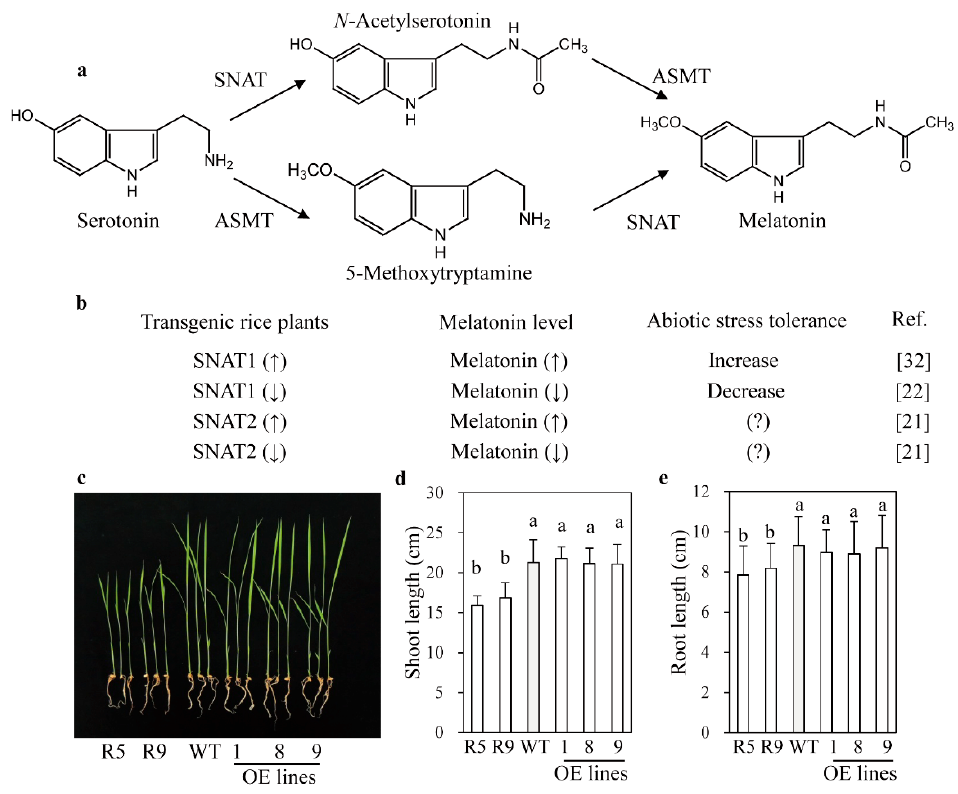
Figure 1. Phenotypes of snat2 and SNAT2 OE rice seedlings. ( a ) Melatonin biosynthetic pathway in plants. ( b ) Relationship between SNAT gene expression and stress tolerance. ( c ) Seedling phenotypes. ( d ) Shoot length. ( e ) Root length. Germinated seeds were grown under a 14-h light/10-h dark cycle for 12 days. Values are means ± standard deviation from three independent experiments. Different letters indicate significant differences, as determined by a post-hoc Tukey’s honestly significant difference (HSD) test at p < 0.05. R5 and R9: SNAT2 RNAi lines; OE, SNAT2 overexpression lines; WT, wild type. ↑ denotes increase and ↓ means decrease on melatonin level. ? denotes no data available.